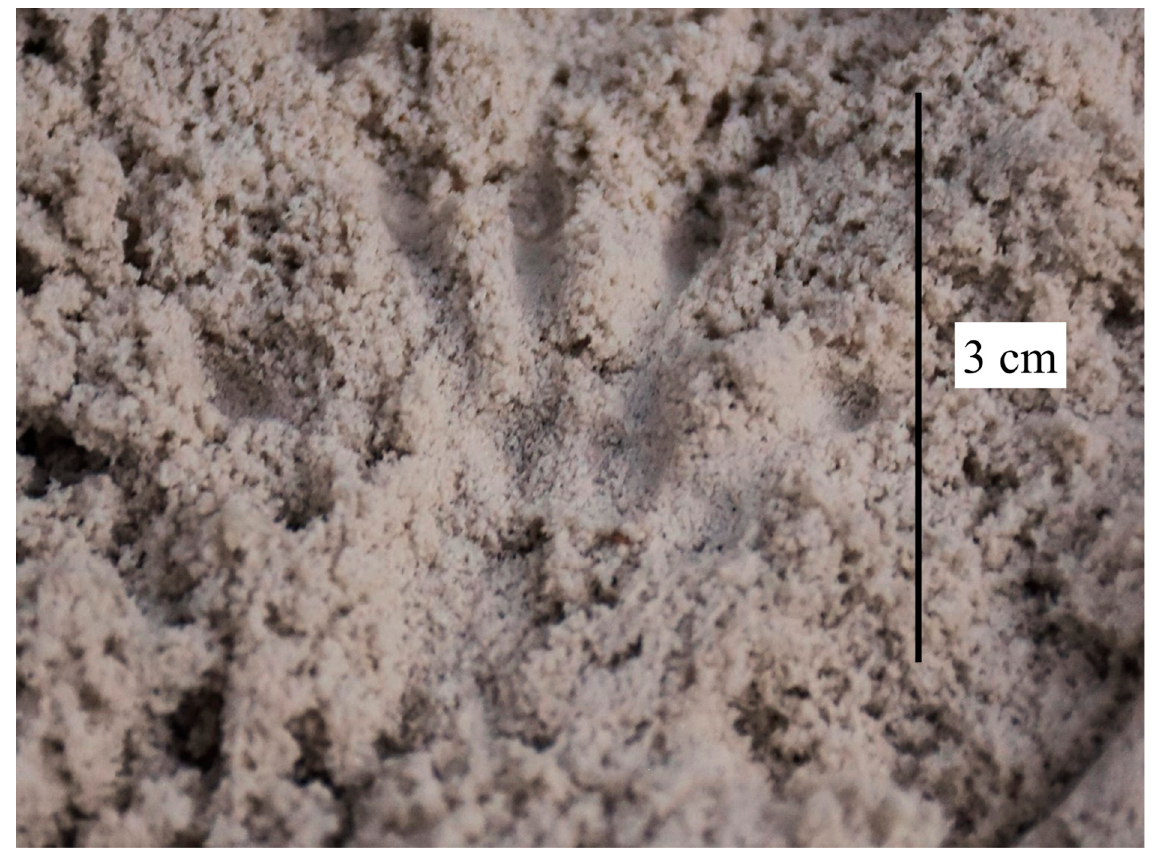
Figure 5. Single track of a water vole imprinted in kinetic sand (photo by Z. Wikar).